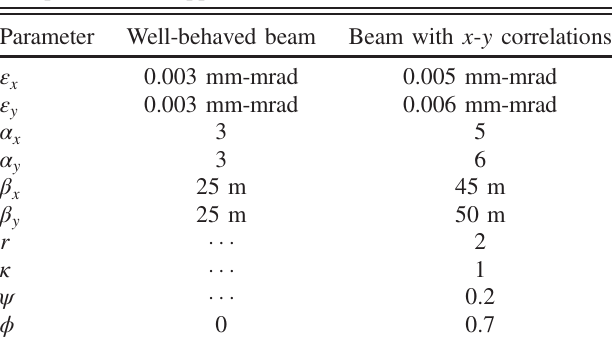
TABLE I. Transverse beam distributions used in simulation. The beam matrix can be generated according to the parametriza- tion presented in Appendix B.